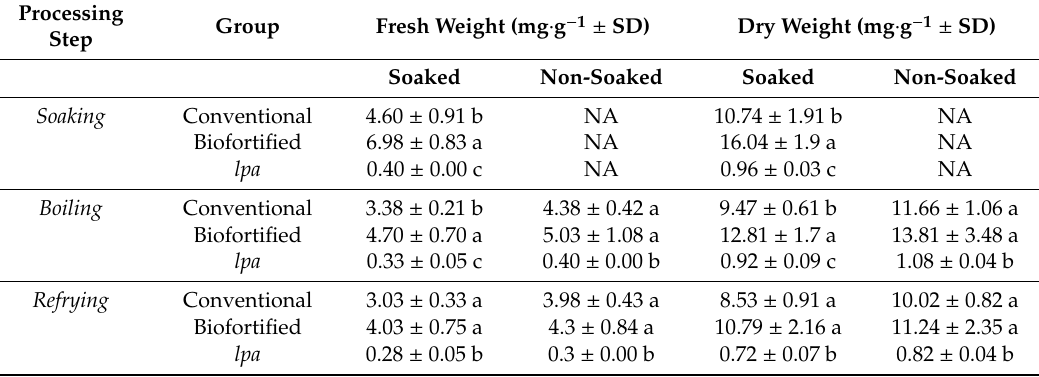
Table A3. Fresh and dry weight (mg · g − 1 ± SD) for total phytic acid of three groups of beans after five di ff erent processing